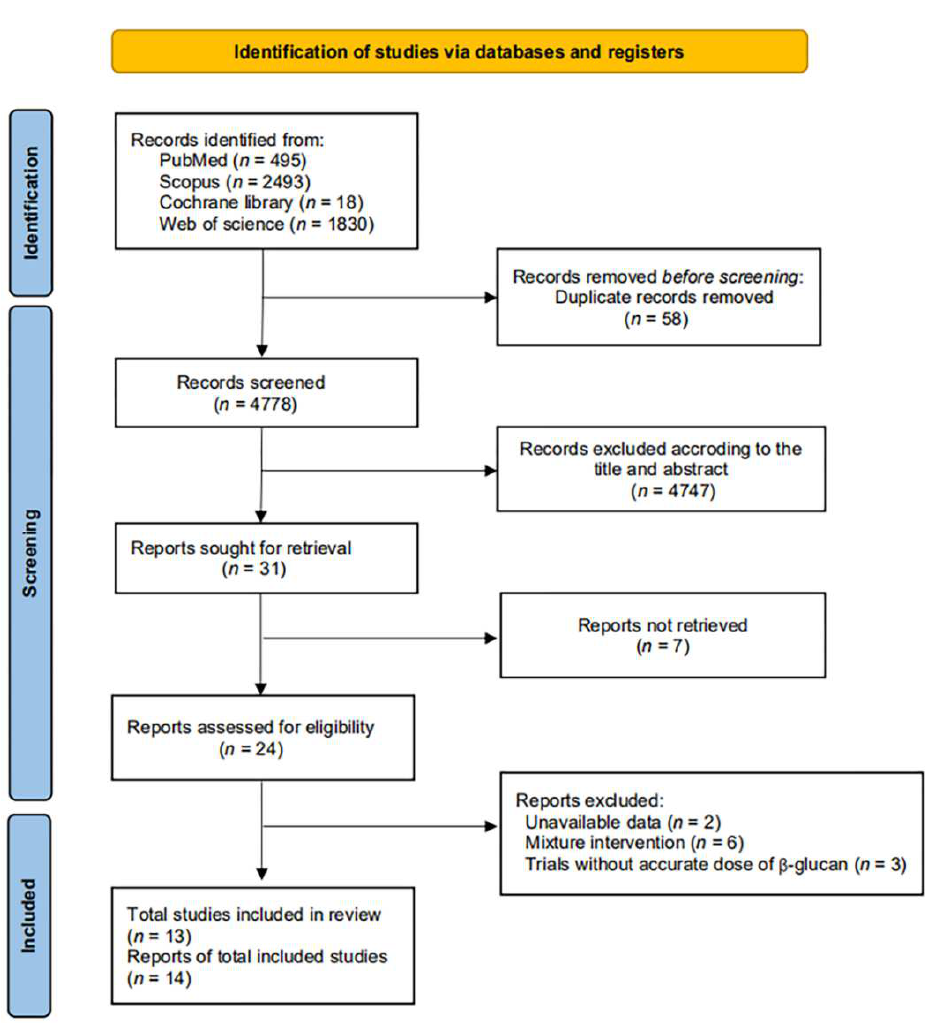
Figure 1. Flow Figure 1. Flow chart.